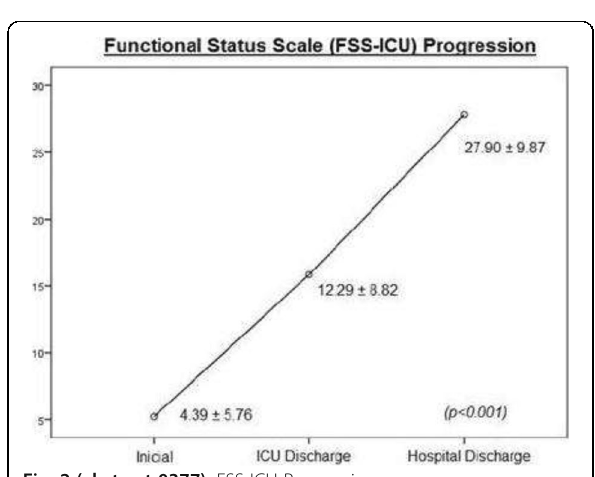
Fig. 2 (abstract 0377). FSS-ICU